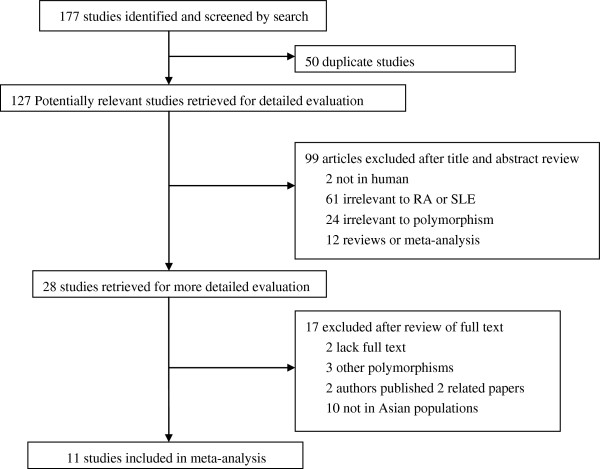
Flow diagram summarizing the search strategy for meta-analysis of IL-18 gene and RA and SLE.